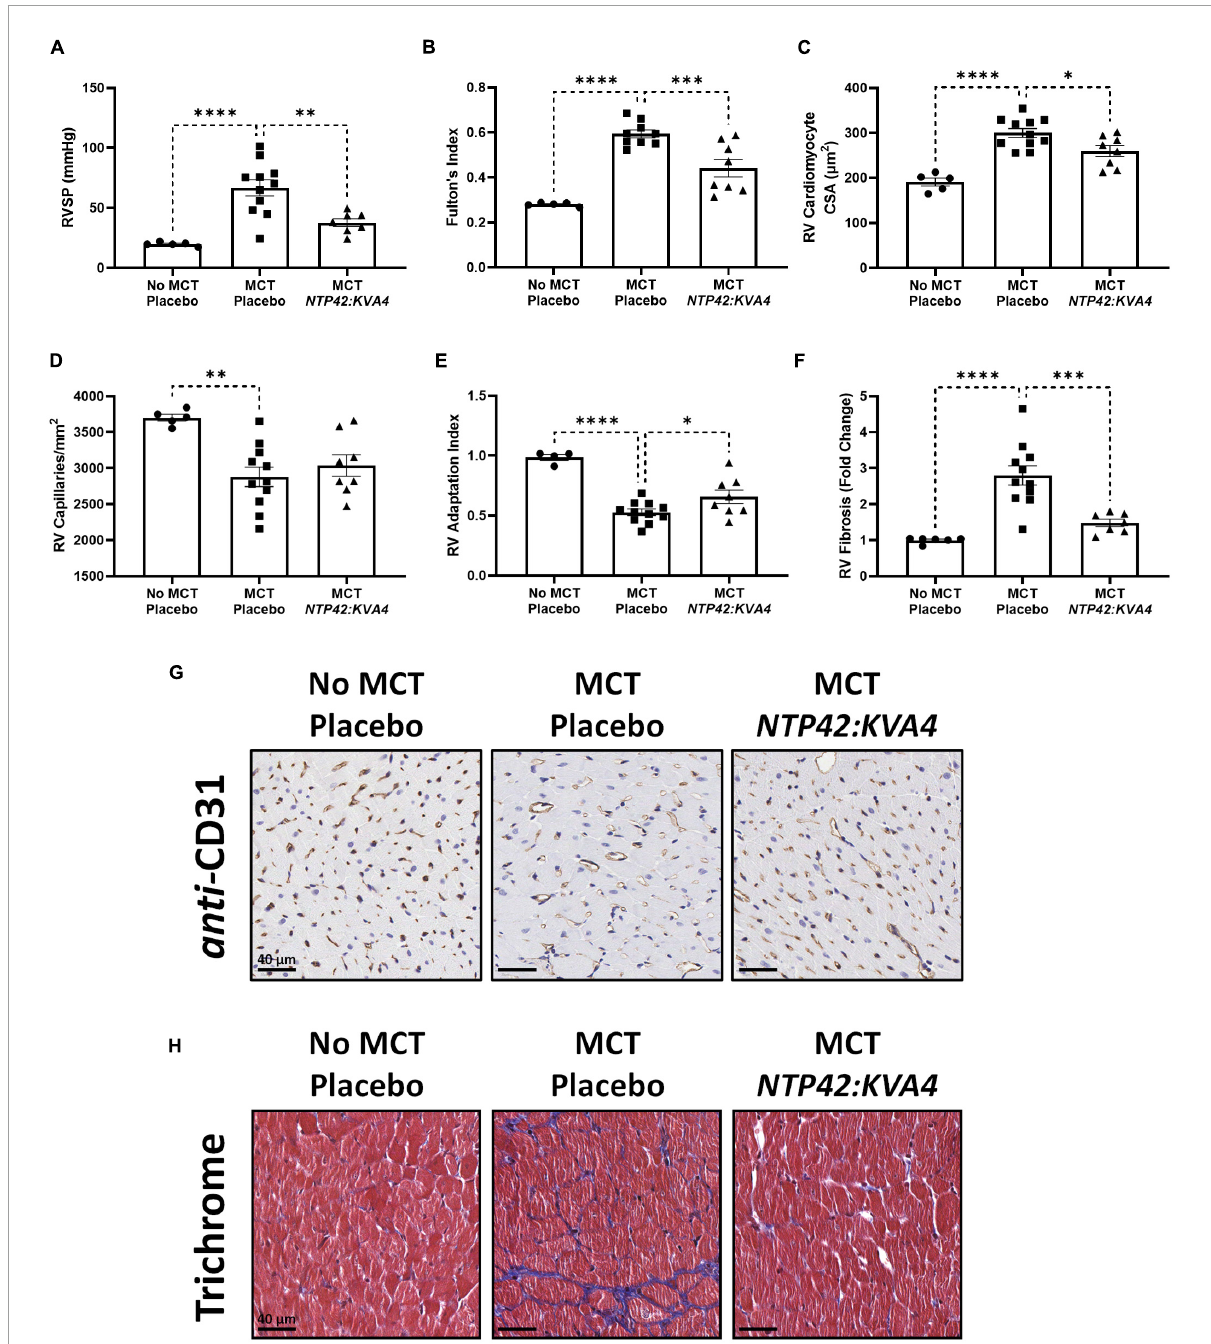
FIGURE1 Effect of NTP42:KVA4 treatment on RV hypertrophy and pathology in the MCT-PAH model. Normal control rats (“No MCT—Placebo”) and rats injected with MCT (60 mg/kg) were treated twice daily orally (PO BID) with either drug placebo (“MCT—Placebo”) or NTP42:KVA4 (1 mg/kg PO BID), starting from Day 7 following administration of MCT. (A–F) show: (A) RVSP in the “No MCT—Placebo,” “MCT—Placebo,” and NTP42:KVA4 groups [ n = 5, 11, 7], (B) Fulton’s Index [ n = 5, 9, and 8, respectively]; (C) RV cardiomyocyte size [ n = 5, 11, 8]; (D) RV vascularization [ n = 5, 11, 8]; (E) RV adaptation index [ n = 6, 11, 8], and (F) RV fibrosis [ n = 5, 11, 7]. Data presented are the mean ± SEM. * P < 0.05, ** P < 0.01, *** P < 0.001, **** P < 0.0001 vs. “MCT—Placebo,” according to one-way analysis of variance (ANOVA) with Holm-Šídák correction applied for